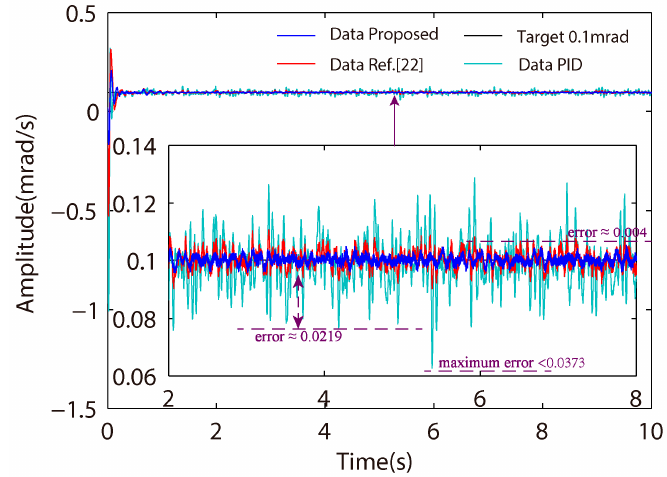
Figure 9. Contrast curve of rated speed 0.1 mrad/s experiment.